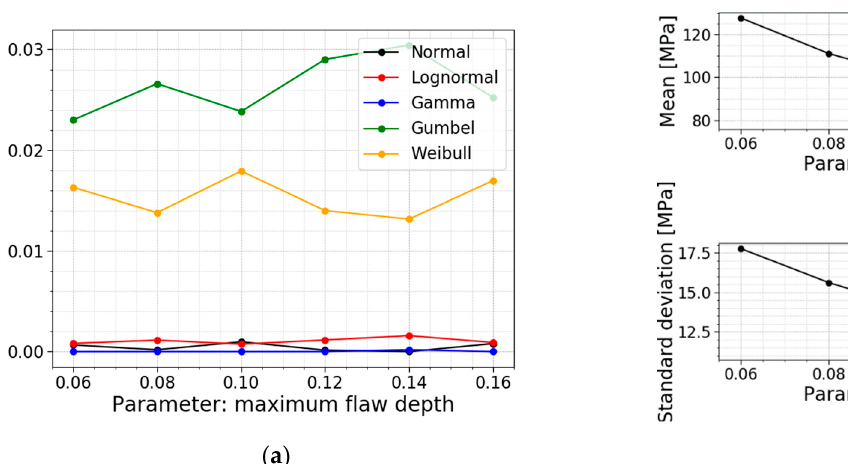
Table 9. Data for a varying maximum flaw depth.